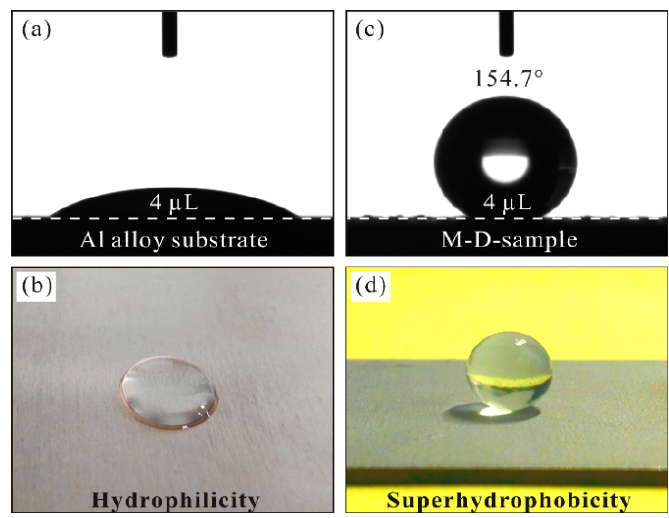
Figure 2. Water contact angles of ( a ) substrate and ( c ) modified deposited sample (M-D-sample). Optical photos of droplets (20 μ L) on ( b ) substrate and ( d ) modified deposited sample.